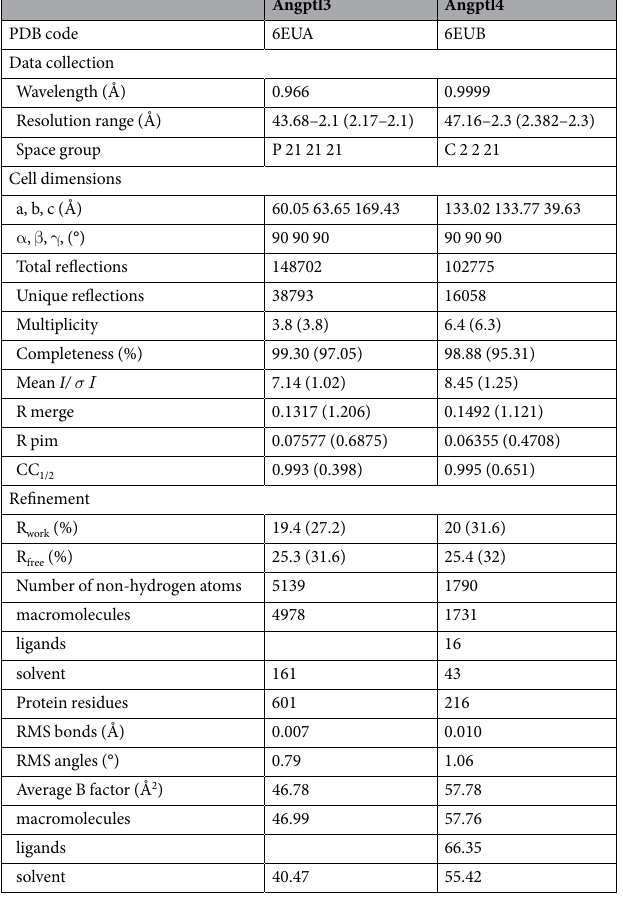
Table 1. Data collection and refinement statistics. Statistics for the highest-resolution shell are shown in